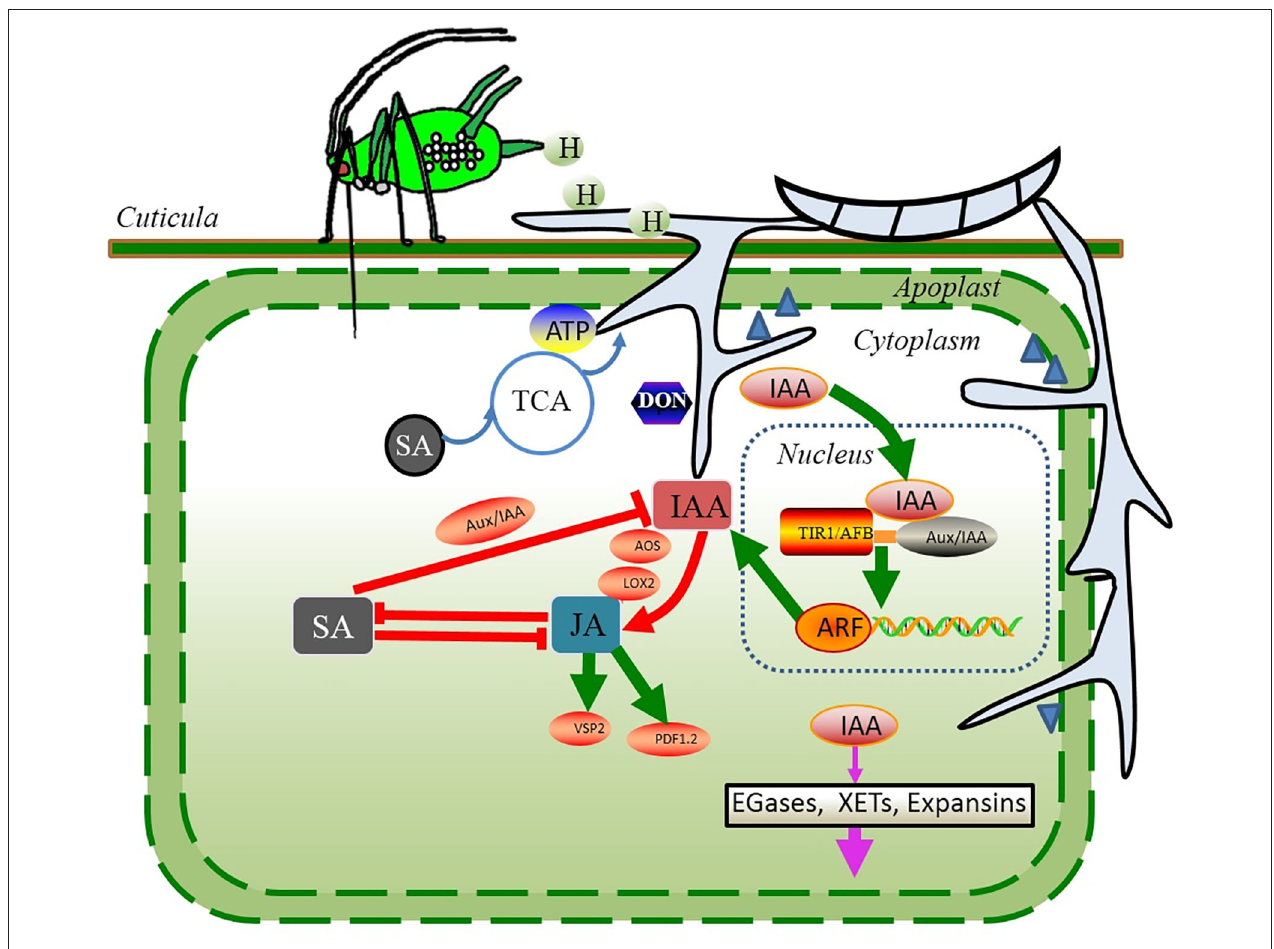
FIGURE 3 | Potential strategies during the first few days of F. graminearum infection (biotrophic phase) in wheat continuously infested by S. avenae . S. avenae and their endosymbionts excrete a large amount of honeydew, which may provide ready-to-use carbon and nitrogen nutrients to accelerate the colonization of F. graminearum . To diminish the SA-dependent responses induced by aphid preinfestation, F. graminearum could metabolize exogenous SA as a source of carbon or manipulate host physiology to produce auxins that would fine-tune the host immune response. Auxins may attenuate the SA-dependent responses, possibly by activating the expression of JA biosynthesis-related genes and JA-regulated defense genes. Red solid lines represent the hormone-mediated upregulation (arrow) or inhibition (blunt-end line). Black blunt-end lines represent the inhibitory effects between the transcription factors. Moreover, F. graminearum significantly upregulates the expression of genes associated with the plant cell wall-degrading enzymes. Steel blue triangles depict the plant cell wall-degrading enzymes secreted by F. graminearum . Green lines and arrows indicate the pathways for IAA, JA, and SA signaling. Pink arrows indicate the pathway by which IAA weakens the plant cell wall. Blue lines and arrows indicate the pathways of SA